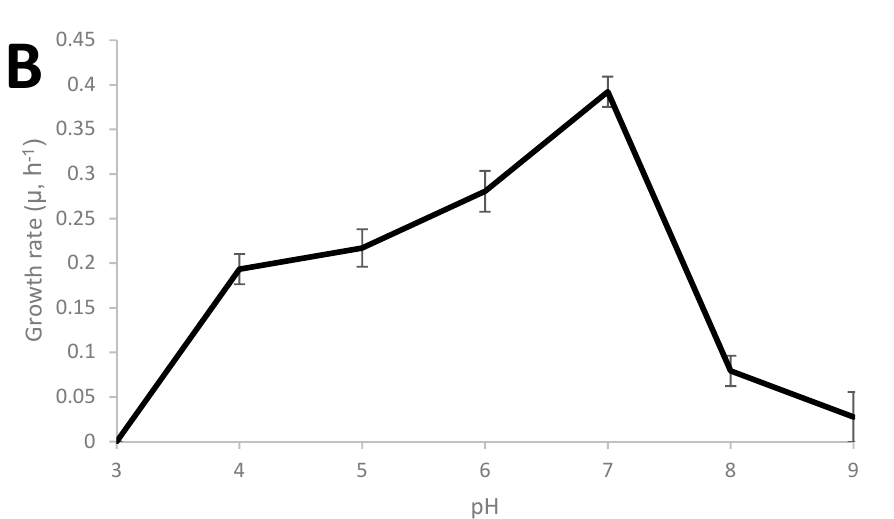
Figure 1. Growth characteristics of Thermoanaerobacter strain AK152; influence of cultivation temperature at pH 7.0 (A) and pH at 70 °C (B) .